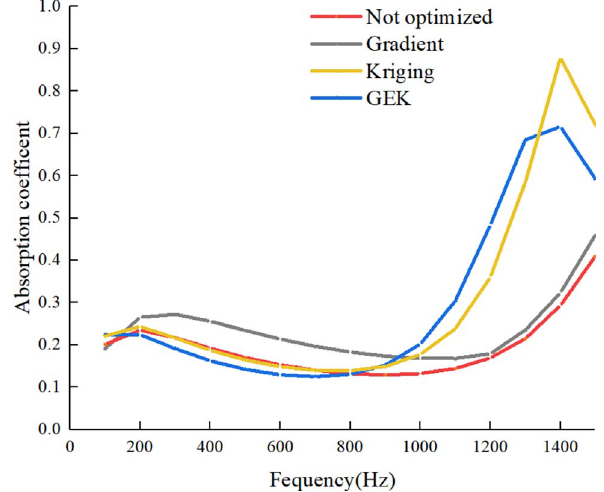
Figure 9. Convergence history of design objective function at low frequency.